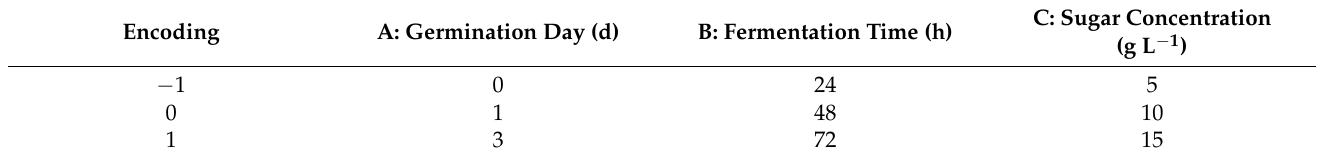
Table 1. Factors and levels of response surface